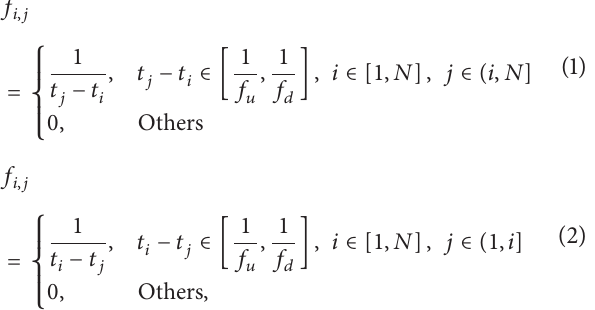
time of the 𝑖 th shock pulse, with s as its unit; 𝑥(𝑡 𝑖 ) denotes the amplitude of the 𝑖 th shock pulse, with m / s 2 as its